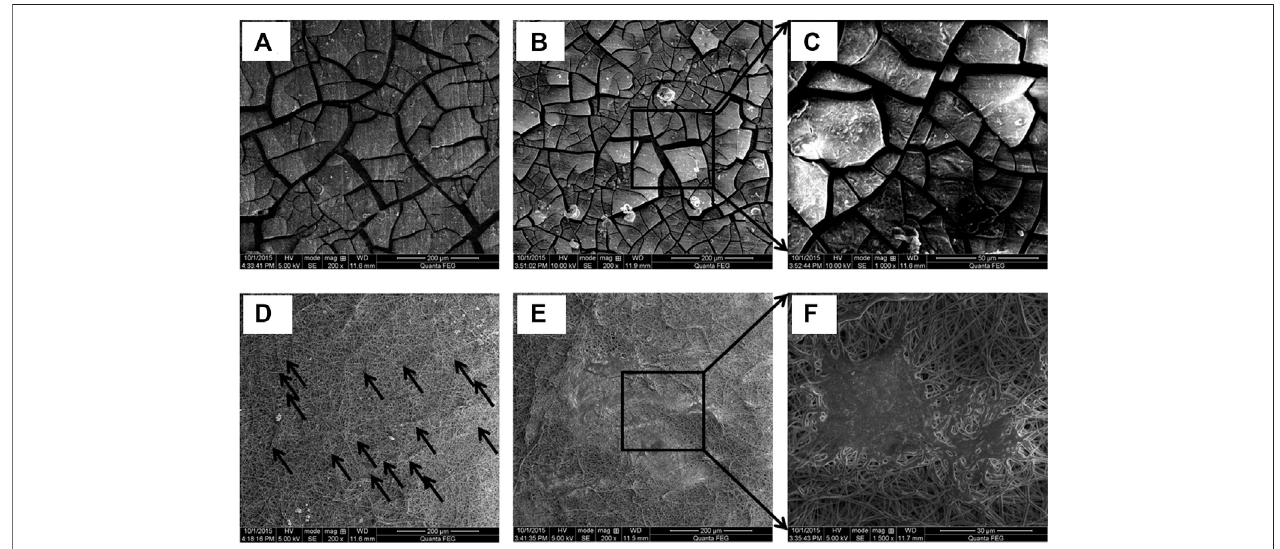
FIGURE 8 | Characteristic morphology of electrospun AZ31 alloy, after cell culture: (A) uncoated after 1 day, (B) and (C) after 3 days, (D) PCL/nHA composite coated after 1 day, and (E) and (F) after 3 days. Reprinted from (Hanas et al., 2018), Copyright 2018, with permission from